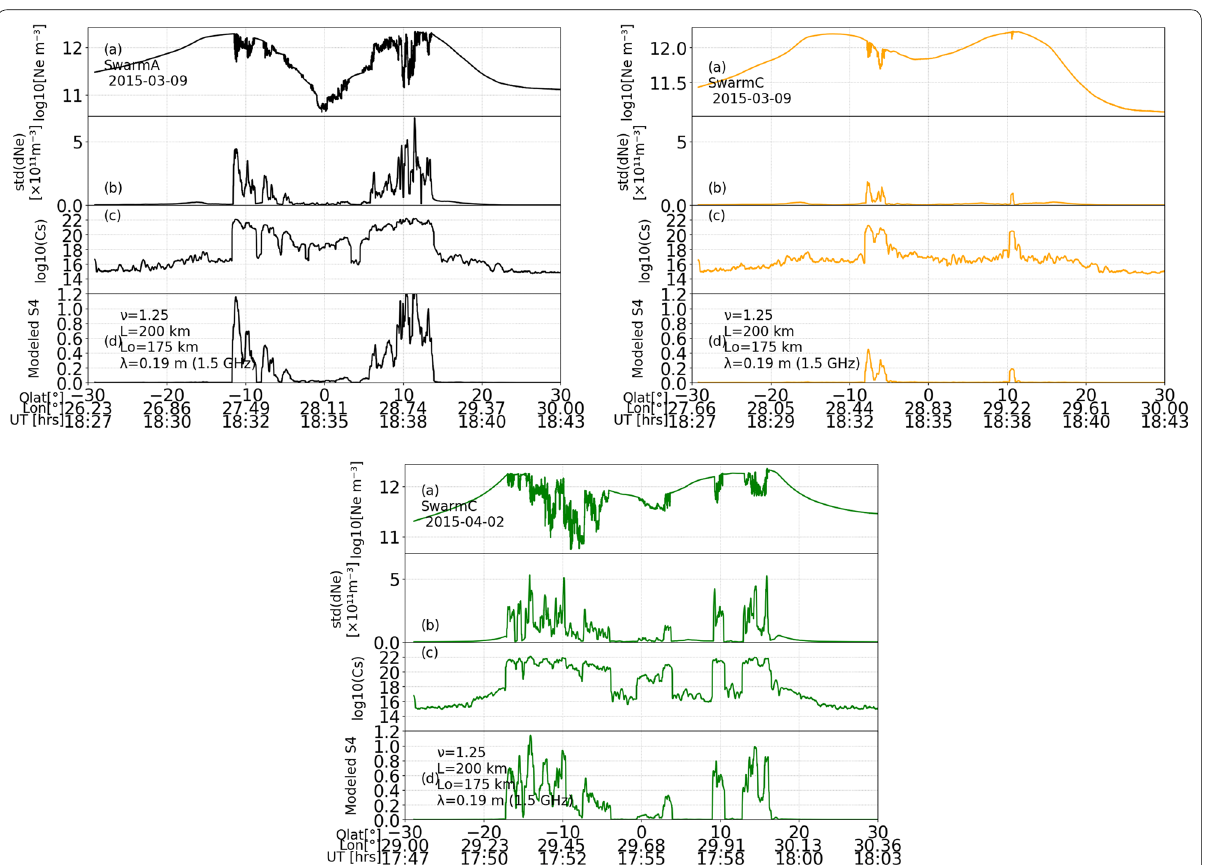
Fig. 11 Examples of model results for Swarm A and C on 2015-03-09 and Swarm B on